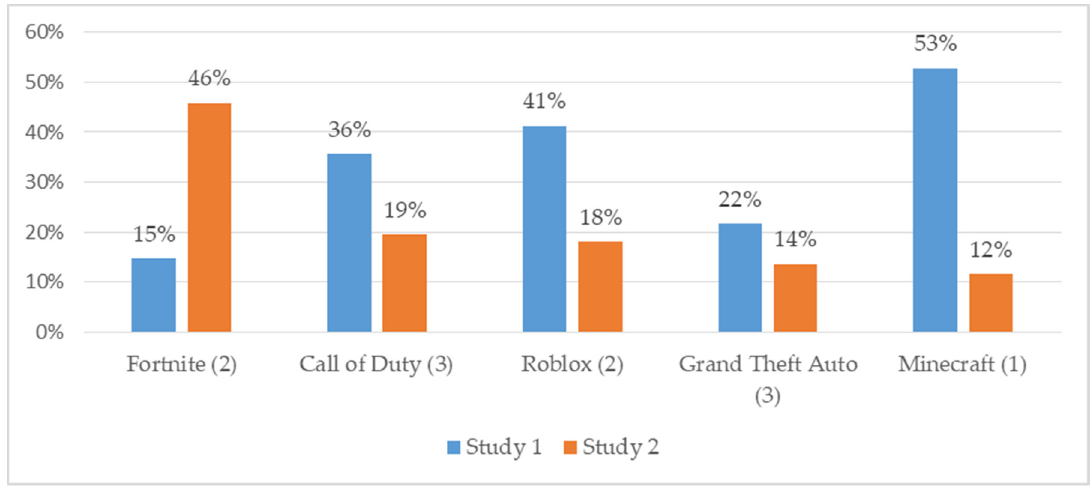
Figure 1. Top 5 most popular games played (risk level).